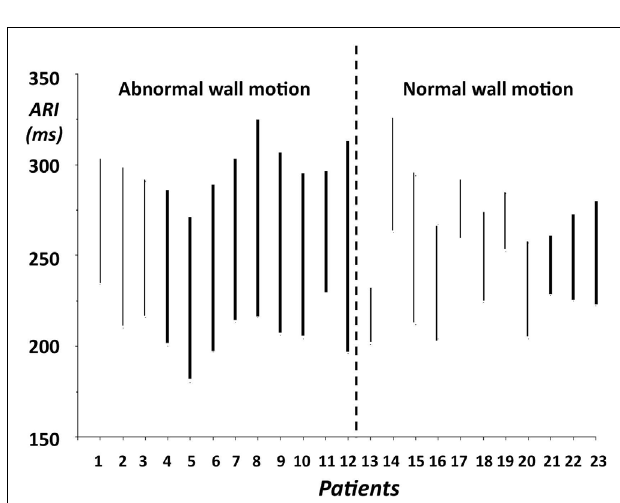
FIGURE 3 | Minimum and maximum activation-recovery intervals (ARIs) in 23 patients (1–12 withWMA, 13–23 with normal wall motion; patient groups separated by dashed line between patients 12 and 13). Thin lines: patients without myocardial infarction, bold lines: patients with myocardial infarction.Whether patients had normal wall motion, or were hypokinetic, akinetic, or dyskinetic can be found in Table 2 , where the order of the patients is similar to that in Figure 3 .